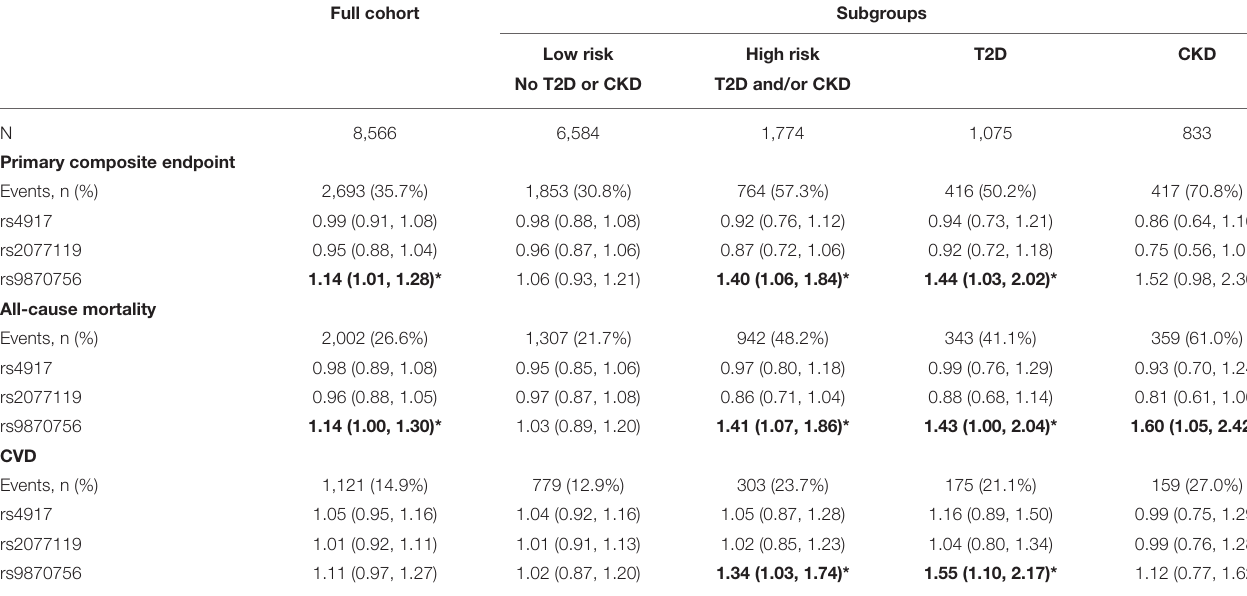
TABLE 3 | Associations of three lead T 50 SNPs with clinical outcomes in the Rotterdam